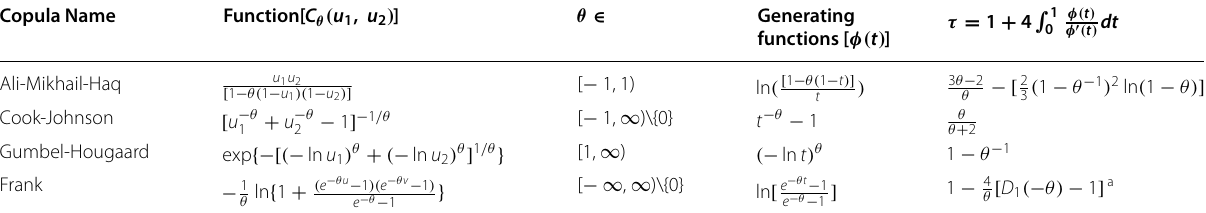
Table 2 Basic properties of applied copulas Copula